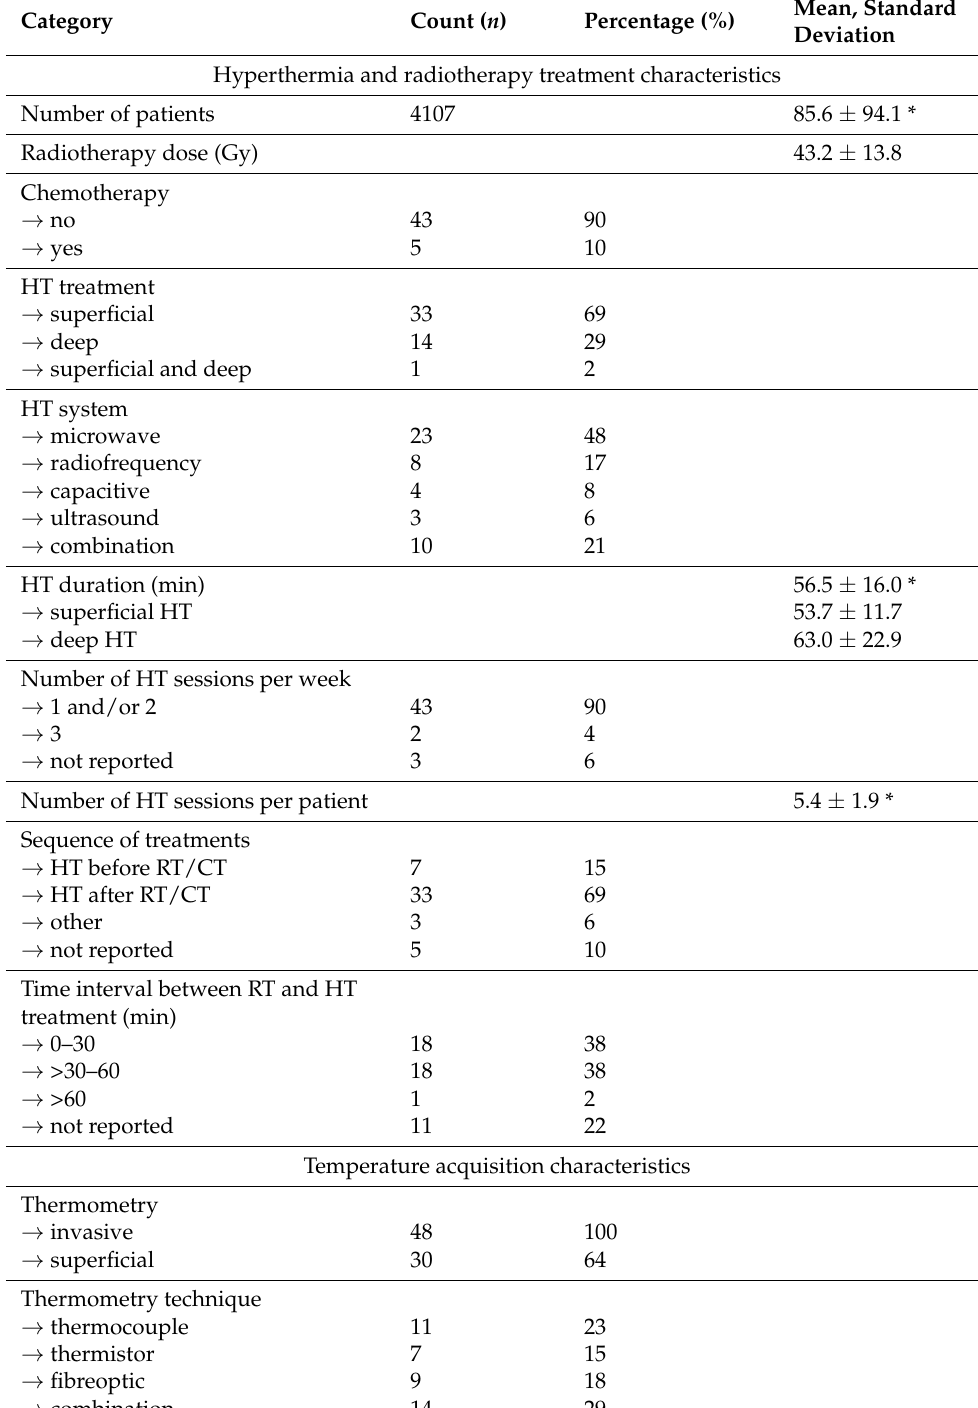
Table 2. Summary of the investigated